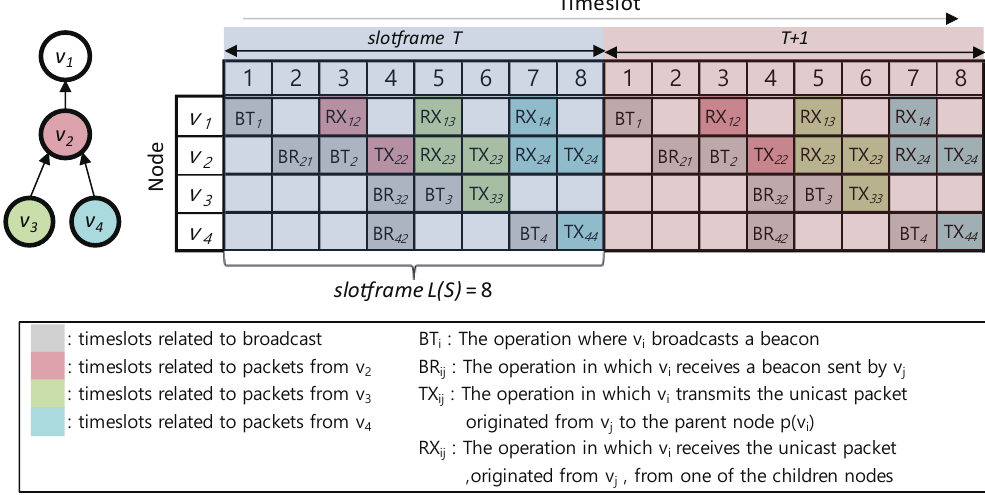
Figure 2. An example of timeslot allocation for the convergecast